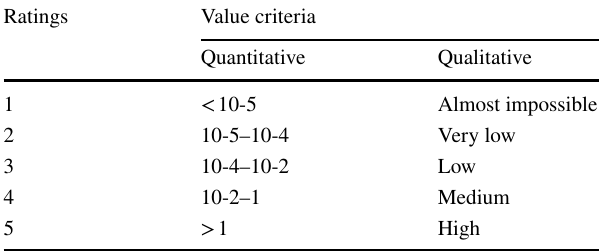
Table 4 Description of the likelihood